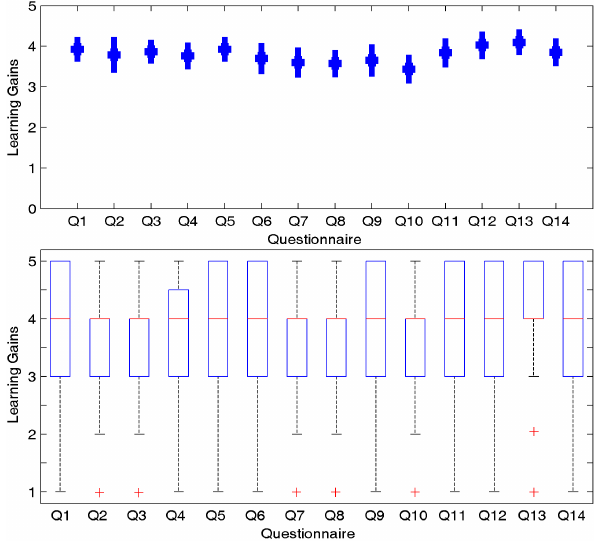
Fig. 5. Students feedback (see Questions 1–15 in Table 1); 1=no gains; 2=a little gain; 3=moderate gain; 4=good gain; and 5=great